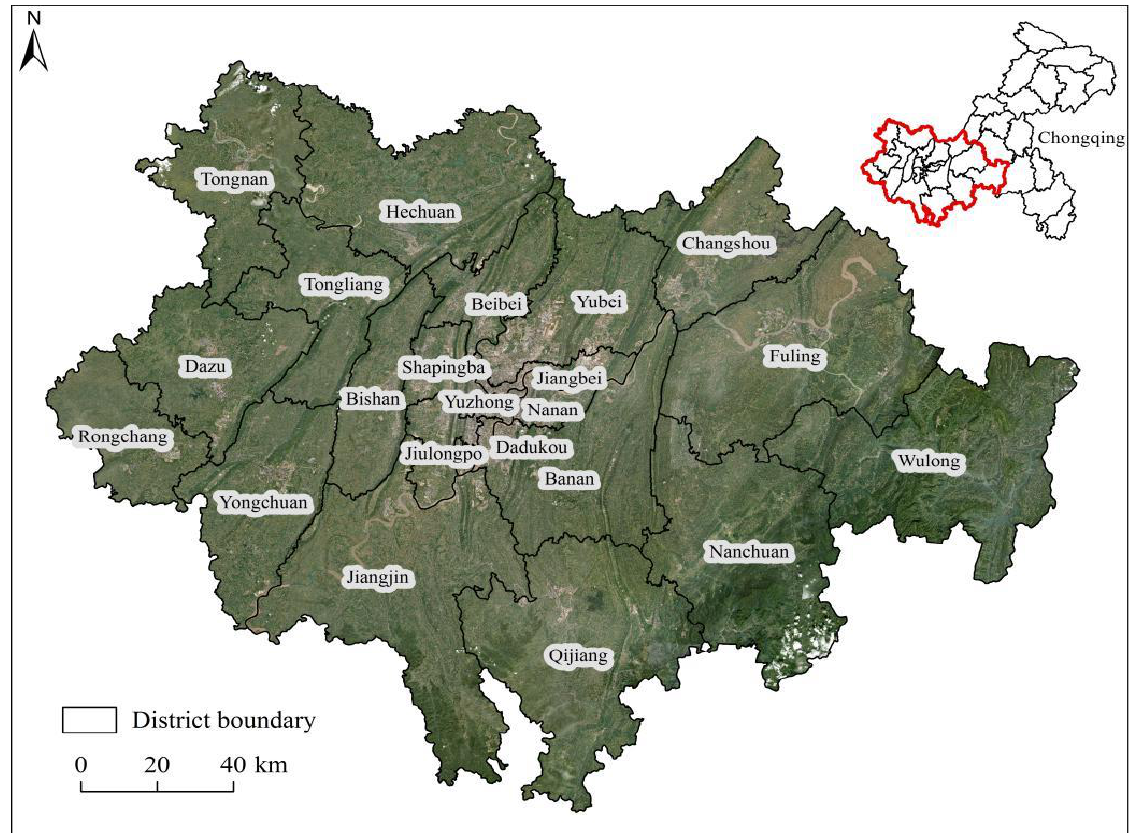
Figure 1. Research area.